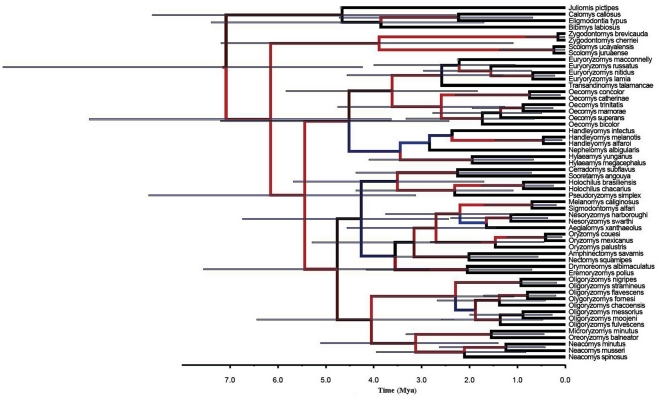
Bayesian consensus tree obtained from 139 ultrametric trees based on an uncorrelated exponential relaxed clock.Blue branches indicate posterior probability values of a node below 0.5. Horizontal blue bars indicate the 95% HPD of divergence times, and the scale axis shows divergence times as millions of years ago (Mya).